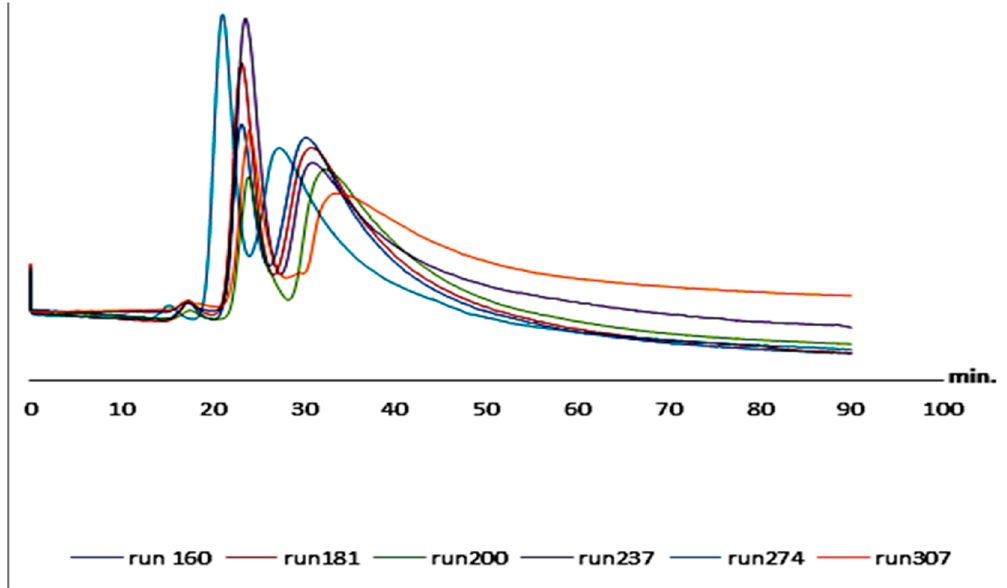
Figure 5. The loadability of the monolithic columns of 4-hydroxy-3-methoxymandelic acid ( 35 ) started at run no. 160 up to run no. 307, on C1 capillary column (150 µm ID, 25 cm length). mobile phase: methanol/water 40:60 v / v , UV: 219 nm, flow rate: 1 µL/min.